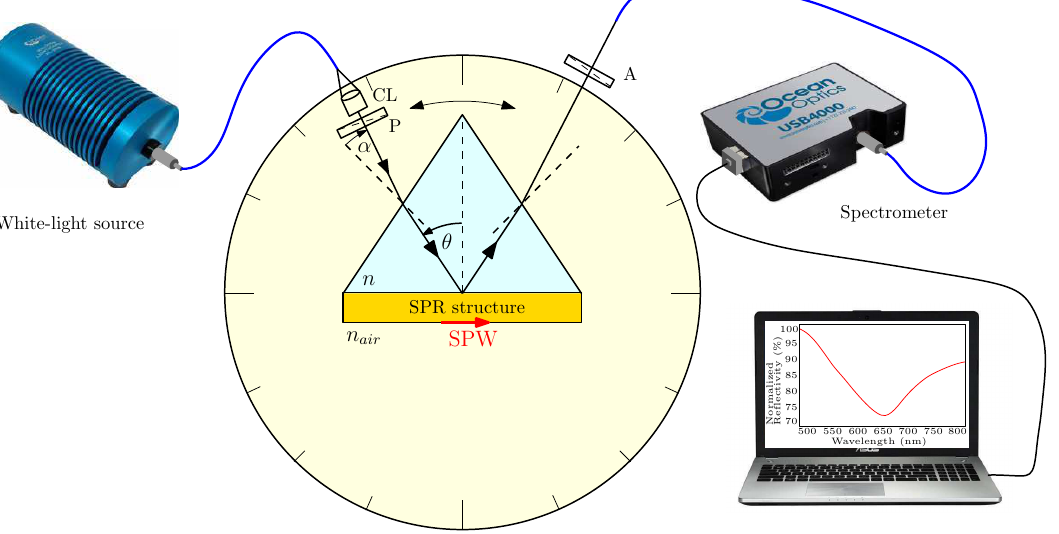
Figure 1. Experimental set-up: an SPR structure in the Kretschmann configuration; collimating lens (CL), polarizer (P), analyser